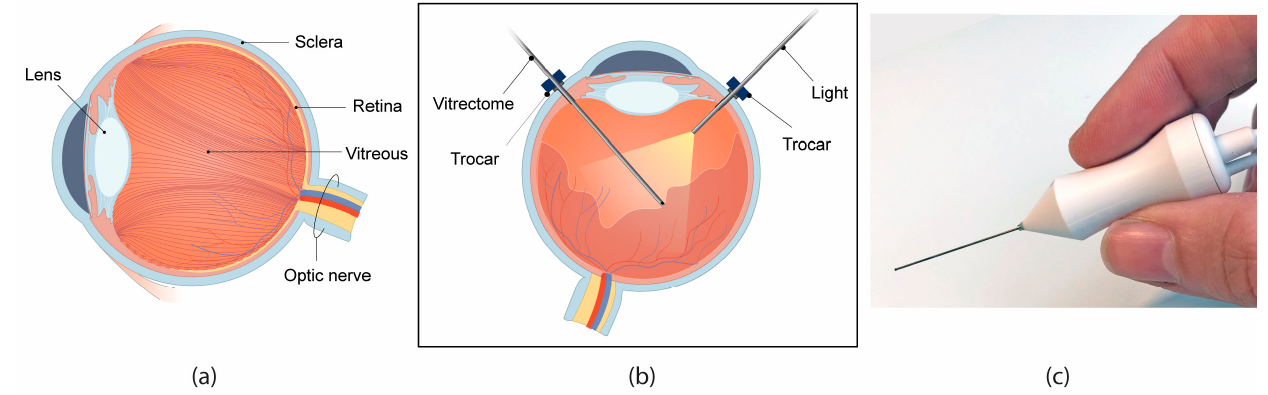
Figure 1. Vitrectomy surgery. ( a ) Schematic cross-section of the anatomy of the eye, showing the orientation of the collagen fibre network in the eye, based on [3]. ( b ) Schematic of the set-up during a typical vitrectomy. ( c ) An example of a commercially available vitrectome as produced by D.O.R.C. (Dutch Ophthalmic Research Centre, Zuidland, The Netherlands).